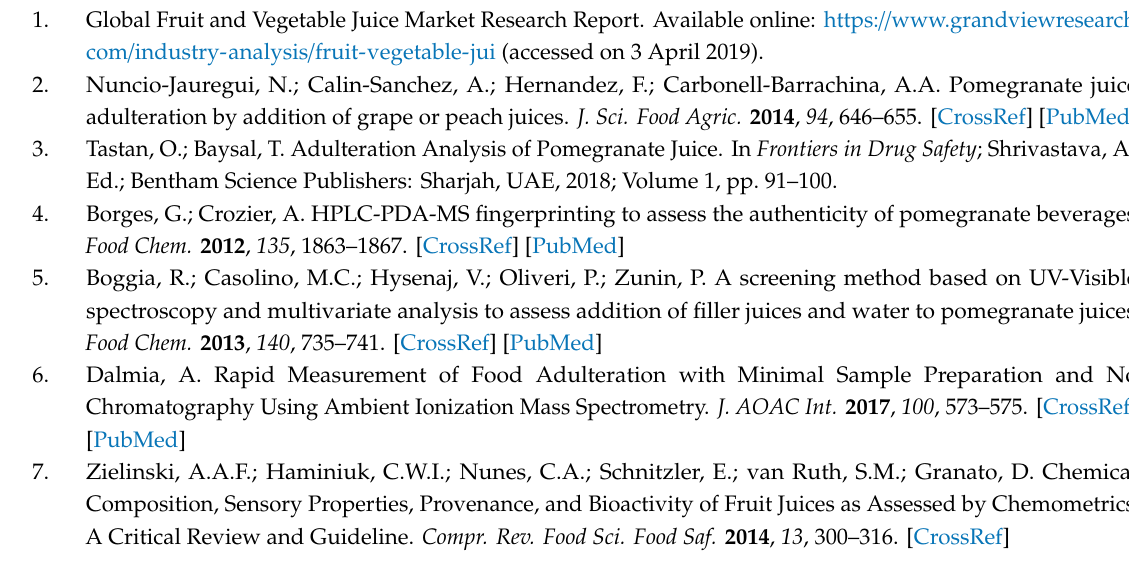
Figure S15: Identification data for the mass feature m / z 389.1242 _4.8 min (resveratrol 3-glucoside), Figure S16: Identification data for the mass feature m / z 295.0464_1.7 min (cis-coutaric acid); Figure S17: Identification data for the mass feature m / z 261.1344_3.0 min (phaseolic acid); Figure S18: Identification data for the mass feature m / z 261.1344_3.0 min (procyanidin